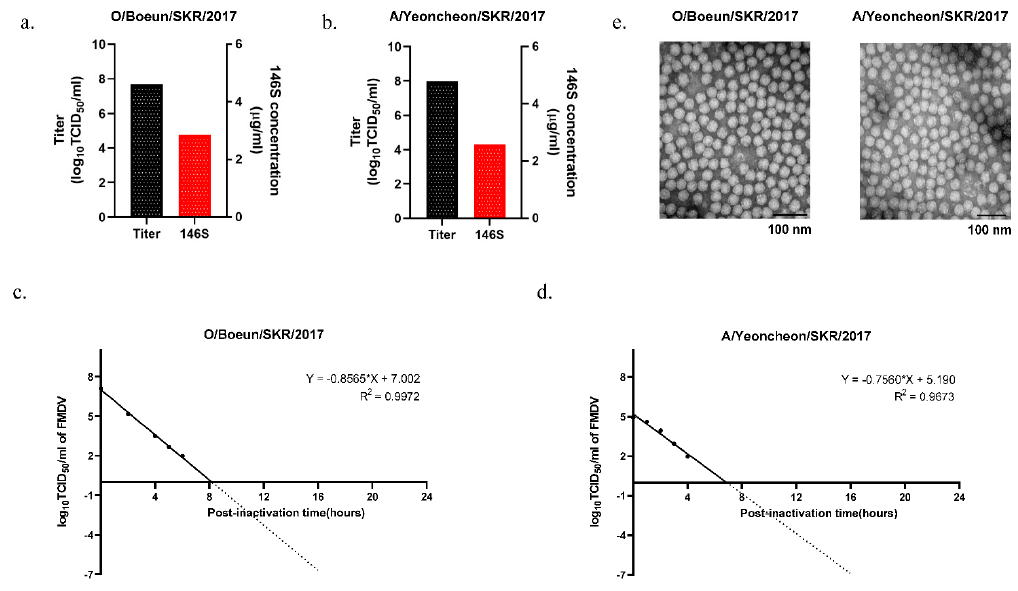
Figure 2. Results of antigen production in a 100 L bioreactor. ( a , b ) Contents of 146S antigen and virus titer from virus supernatant produced by a 100 L bioreactor. ( c , d ) Virus inactivation kinetics after binary ethyleneimine (BEI) treatment. The virus culture supernatant was treated with 3 mM BEI twice (at 0 h and 16 h) and incubated until 24 h. Samples were taken every hour from the bioreactor for 6 h to measure virus inactivation kinetics for each strain of the virus. The extrapolation of the individual graph is drawn as a linear line for the analysis of FMDV inactivation. ( e ) Inactivated 146S antigen was concentrated with PEG, purified using sucrose gradient ultracentrifugation, and observed by transmission electron microscope (TEM). Vaccines 2021 , 9 , x